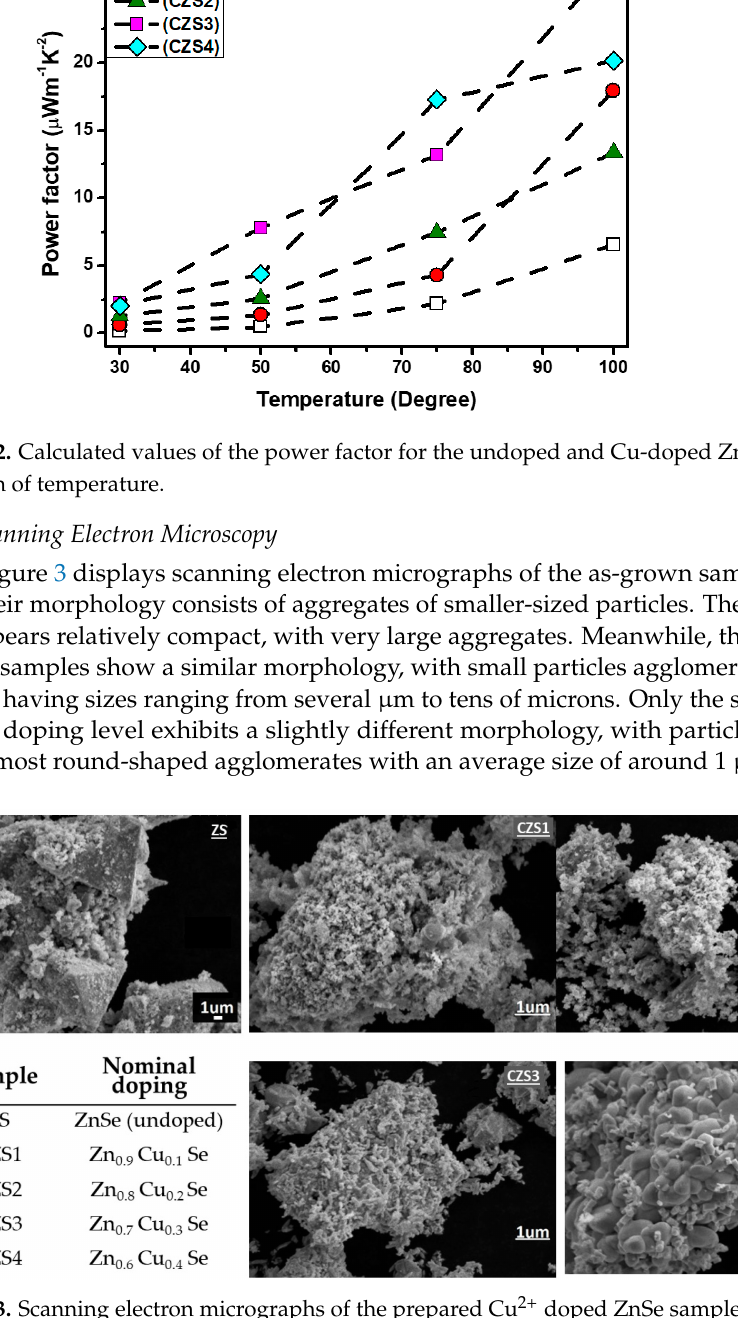
4 of 10 Figure 1. Measured Measured values of the electrical conductivity ( a ) and of Seebeck coefficient ( b ) for the undoped and Cu-doped ZnSe samples, as a function of temperature. The undoped sample displayed a typical semiconducting behavior, with an electrical conductivity of about 140 Scm − 1 at room temperature, which increased to about 390 Scm − 1 as the temperature was raised to 100 °C. As expected for doped semiconductors, as the doping concentration was increased, the electrical conductivity of the samples also in- creased. The electrical conductivity of all the samples increased as the temperature was raised, which is again a common feature of semiconductors. Overall, the results showed that the electrical conductivity of the samples increased from 140.98 Scm − 1 to 827.99 Scm − 1 as the doping concentration and temperature were varied. The positive Seebeck values indicate holes as the predominant charge carriers, re- vealing a p-type behavior, in agreement with previously reported literature studies [27]. The Seebeck coefficient exhibits a general increasing trend with both doping and tem- perature, although its dependence on both factors is not particularly strong. While simul- taneous enhancements in Seebeck coefficient and electrical conductivity have been re- ported several times in the literature [28,29], such occurrences are not common. A com- prehensive understanding of the underlying mechanisms and strategies to exploit them for producing high-performance materials is still unknown. Although dedicated theoret- ical calculations may be required to fully comprehend the physical mechanisms that dic-